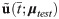
Test 1: FOM, DL-ROM and POD-Galerkin ROM CPU computational times.Left: CPU time required to solve the FOM, by DL-ROM at testing time with n = 3 and by the POD-Galerkin ROM at testing time with Nc = 6 vs. N. The DL-ROM provides the smallest testing computational time for each N considered. Right: FOM, POD-Galerkin ROM and DL-ROM CPU computational times to compute u˜(t¯;μtest) vs. t¯ averaged over the testing set. Thanks to the fact that the DL-ROM can be queried at any time istance it is extremely efficient in computing u˜(t¯;μtest) with respect to both the FOM and the POD-Galerkin ROM.